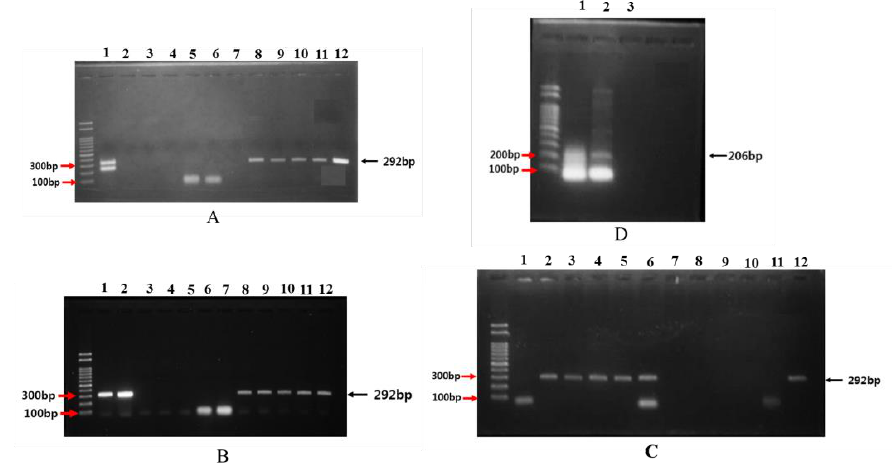
Figure 3. PCR amplification of gene fragments of agrocinopine, nopaline, and octopine of Agrobacterium tumefaciens RC strains. ( A ) From left lane: 1 kb size marker, Lanes 1 (C58), 2 (RC002), 3